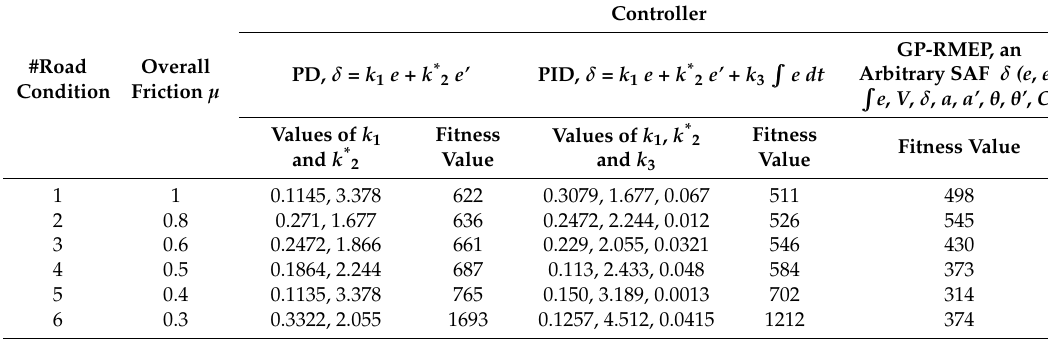
Table 5. Best performing steering